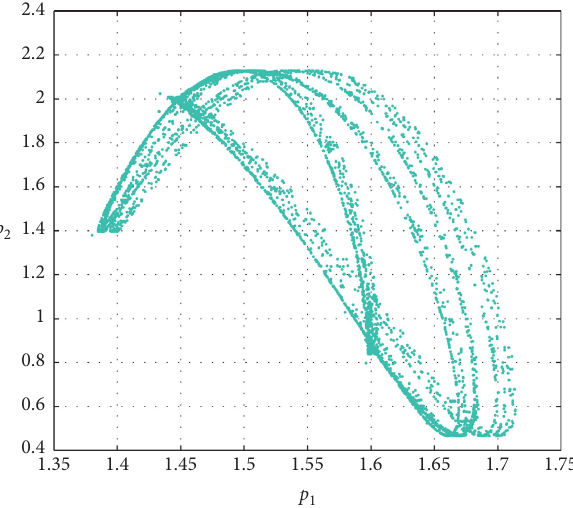
Figure 5: Chaotic singular attractor diagram.